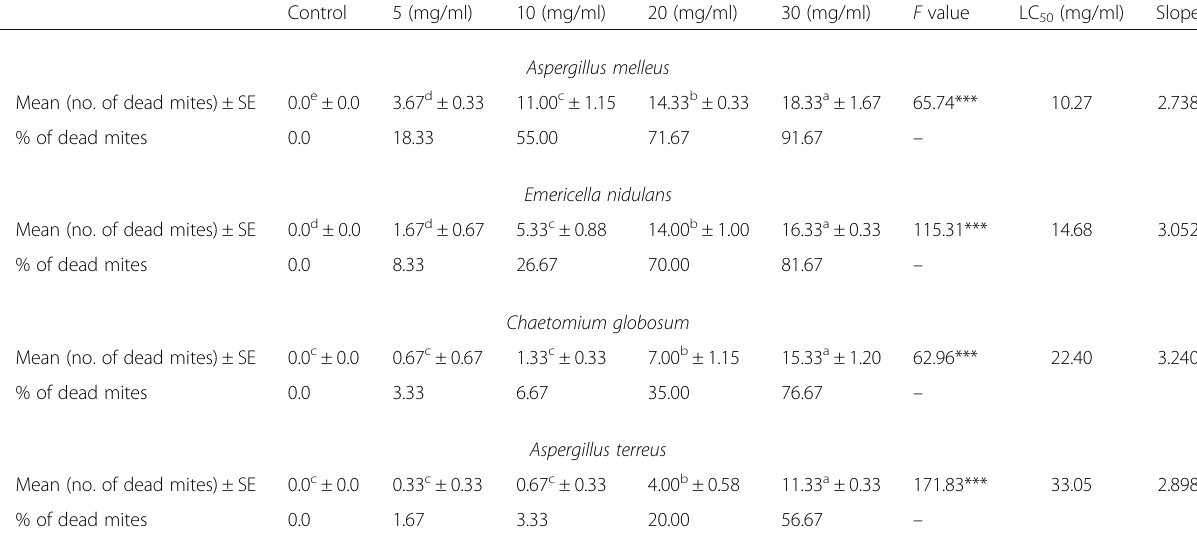
Table 2 Effect of ethyl acetate extract on females of Tetranychus urticae (after 72 h exposure) Control 5 (mg/ml) Aspergillus melleus Mean (no. of dead mites) ±